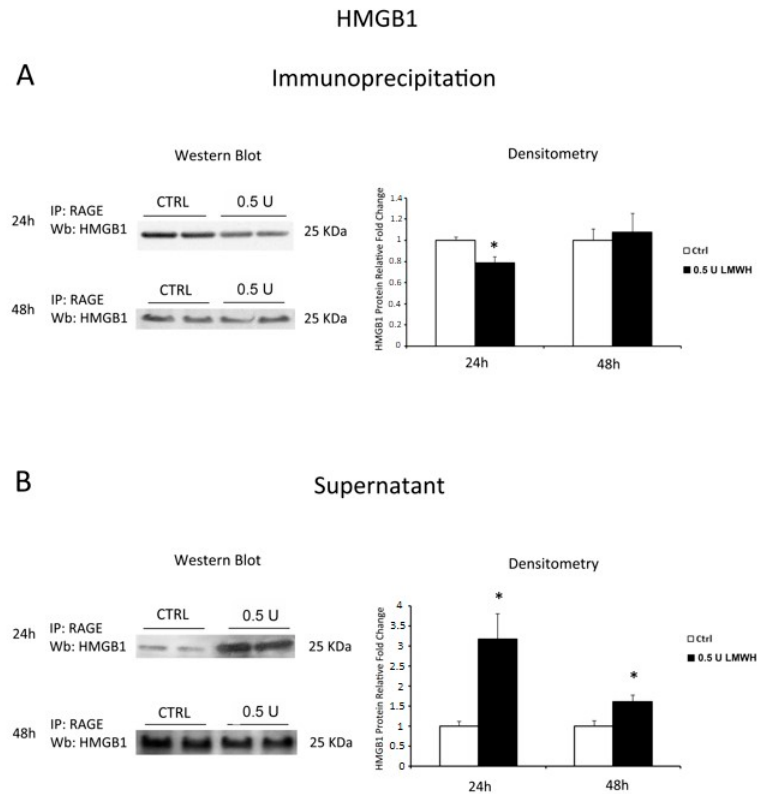
Figure 4. RAGE/HMGB1 binding in LMWH-treated vs. untreated placental villous explants. HMGB1 protein levels were evaluated by western blot after immunoprecipitation with RAGE antibody of protein lysates from placental villous explants treated by 0.5 U of LMWH for 24 h and 48 h. ( A ) Representative WB for HMGB1 protein levels after RAGE IP at 24 h (ctrl n = 16 and 0.5 U LMWH n = 15) and 48 h (ctrl n = 5 and 0.5 U LMWH n = 6); ( B ) Representative WB for HMGB1 protein levels in RAGE IP supernatant at 24 h (ctrl n = 8 and 0.5 U LMWH n = 10) and 48 h (ctrl n = 5 and 0.5 U LMWH n = 6). Statistical significance (*) has been considered as p < 0.05.